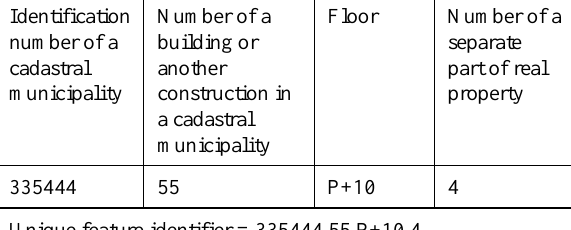
Table 1. An example of forming a unique identifier of a